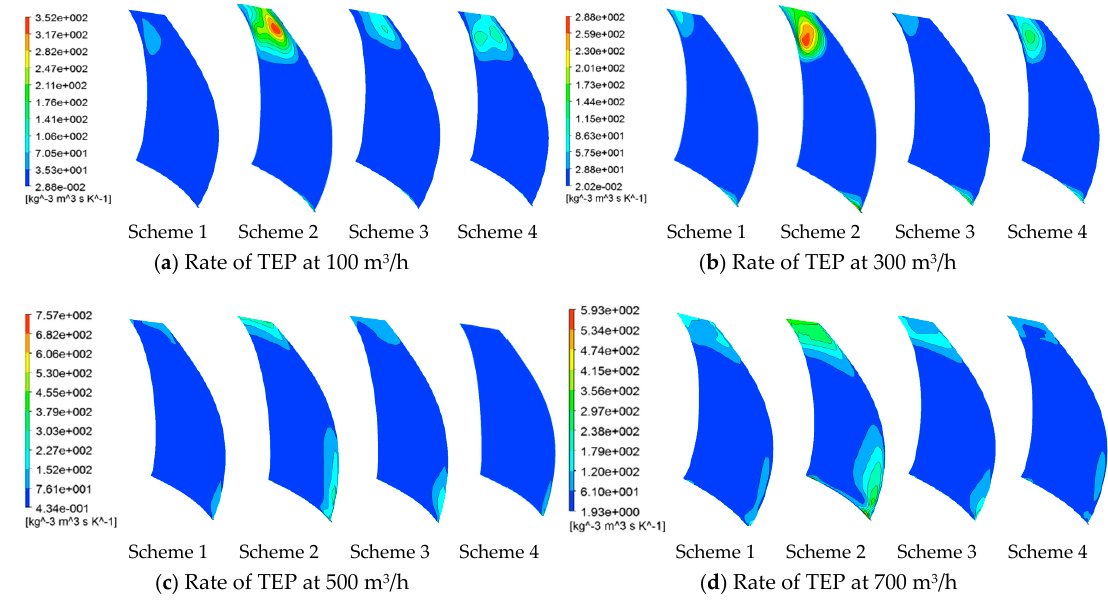
Figure 15. Rate of TEP at various flow conditions [24].